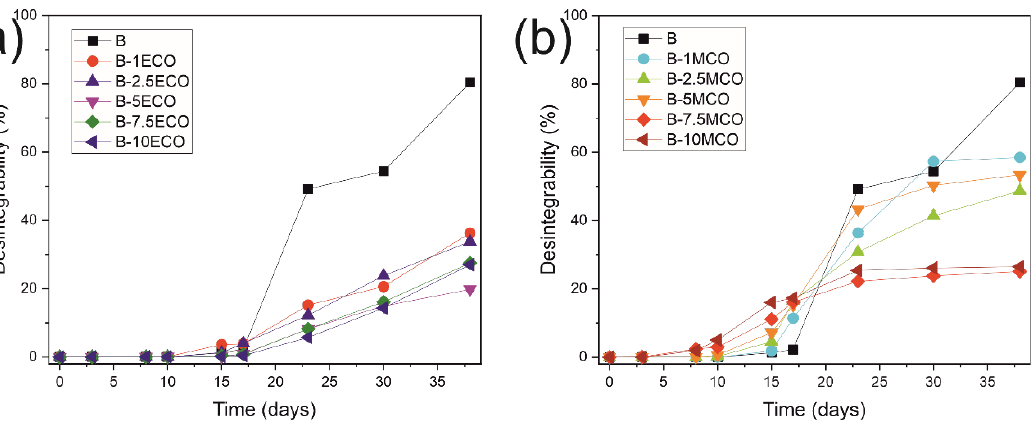
Figure 7. Degree of disintegration under composting conditions expressed as the weight loss as a function of time of (a) PLA – PHB blend and plasticized blend with different ECO content and (b) a function of time of ( a ) PLA–PHB blend and plasticized blend with different ECO content and PLA – PHB blend and plasticized blend with different MCO content. ( b ) PLA–PHB blend and plasticized blend with different MCO